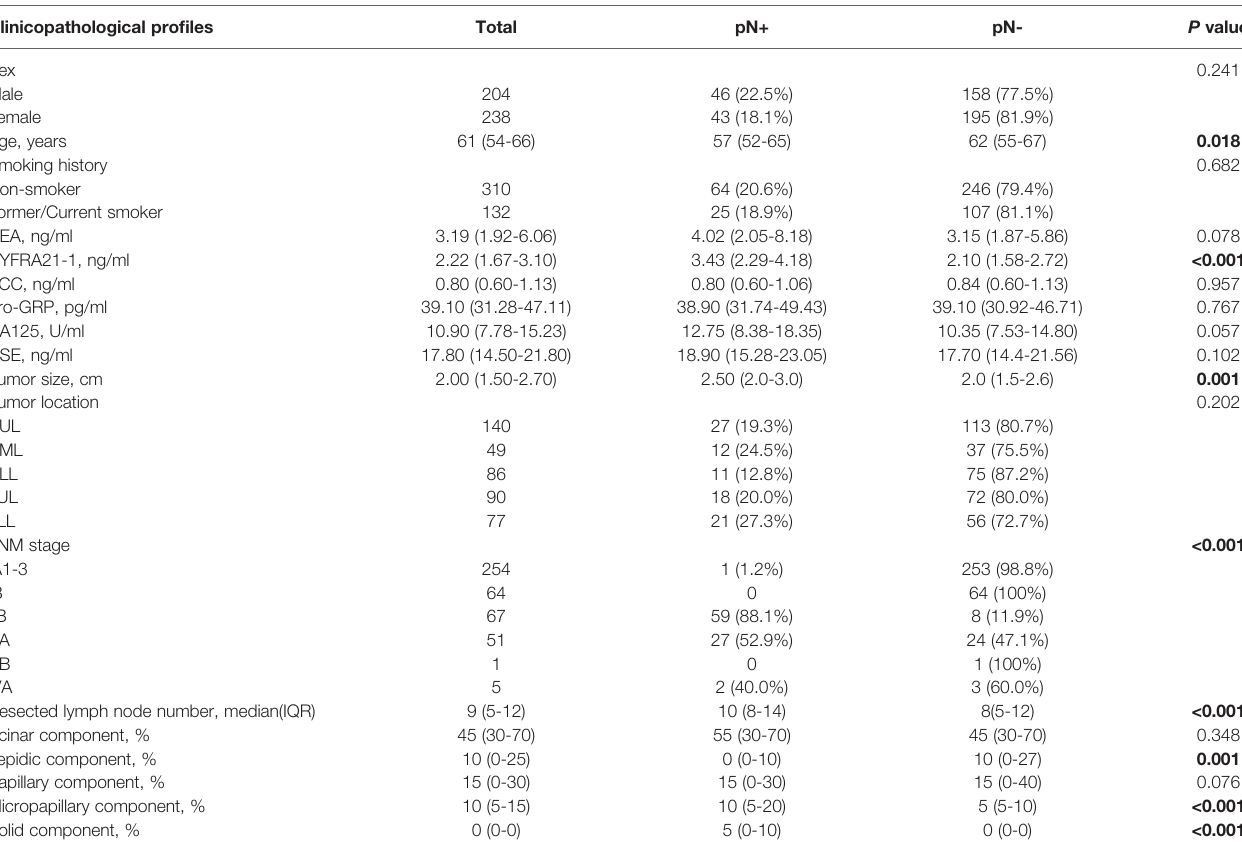
TABLE 1 | Clinicopathological variables in the cohort of enrolled